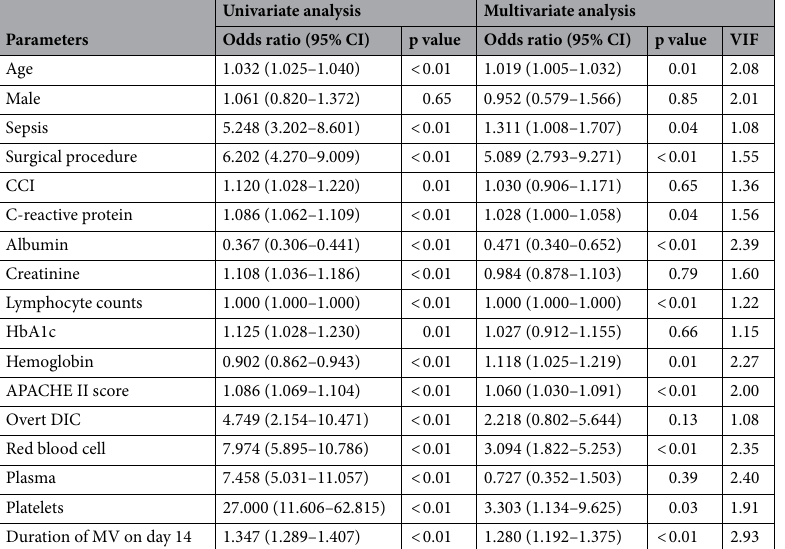
Table 3. Univariate and multivariate analysis of PIICS in the overall cohort. CCI Charlson Comorbidity Index, APACHE acute physiologic and chronic health evaluation, DIC disseminated intravascular coagulation, HbA1c glycated hemoglobin, MV mechanical ventilation, PIICS persistent inflammation, immunosuppression, and catabolism syndrome, VIF variance inflation factor, CI confidence interval.